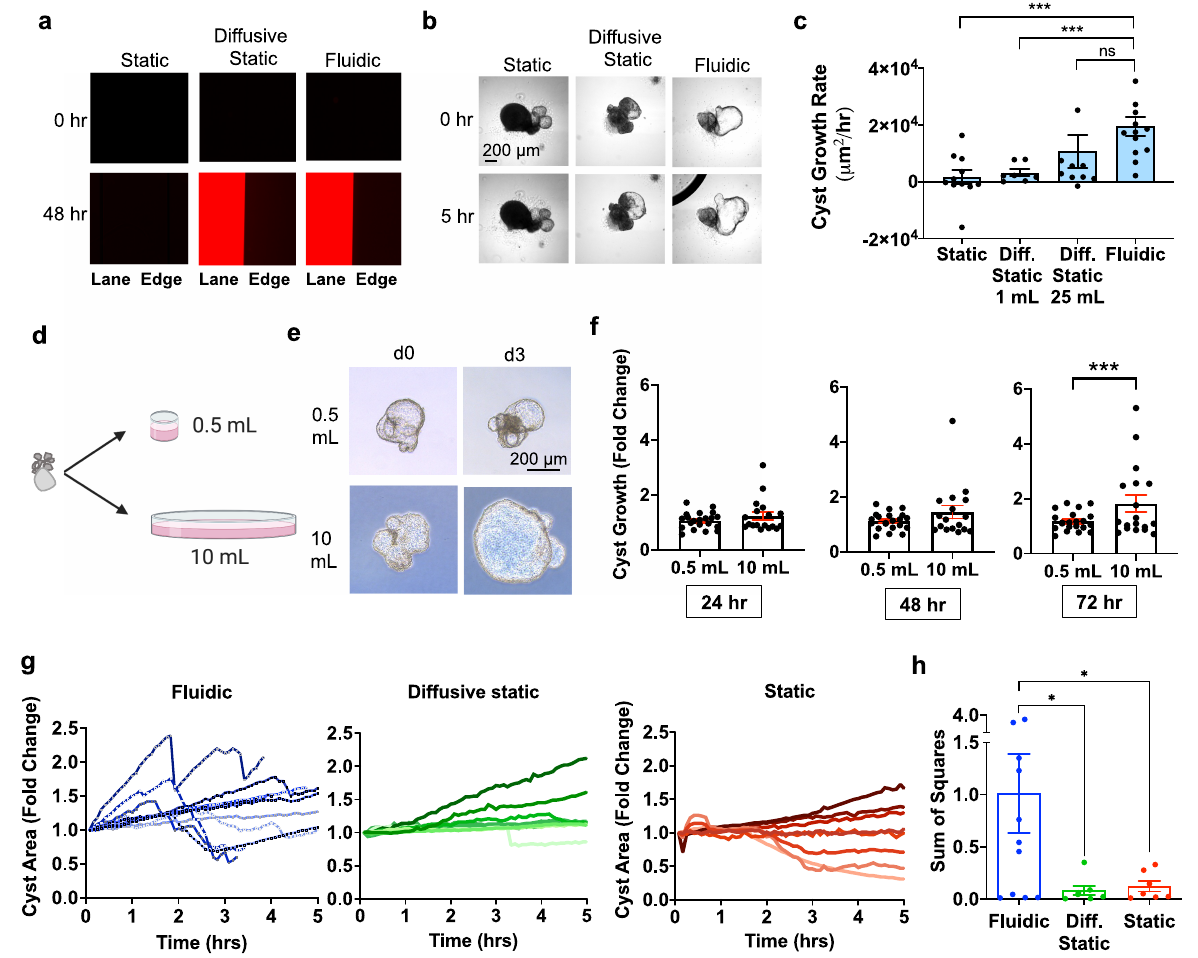
Fig.2|Volumecanpartiallysubstitutefor fl owincystexpansion.a